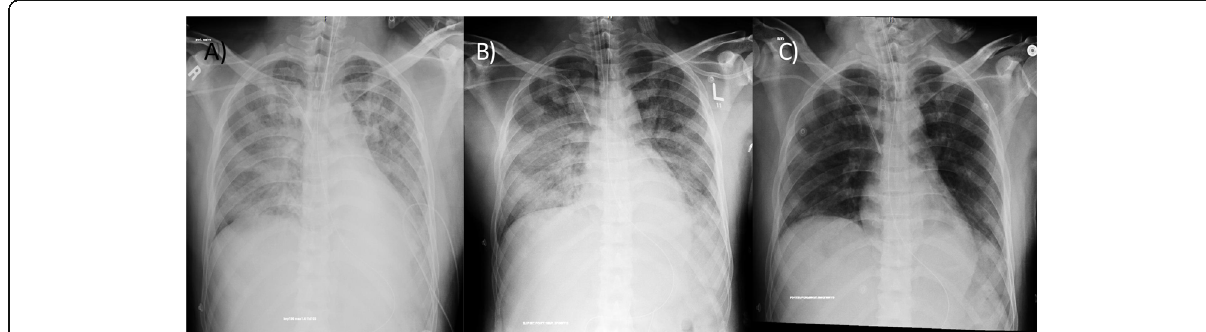
Fig. 6 Case 65: a 38-year-old male, with mild obesity, no other comorbidities, score 7 under vasopressor treatment. Chest X-ray: a day of inclusion (April 16th). Extensive consolidations involving both lung fields with left retrocardiac volume loss. Blunting of the left CP angle. Ill-defined opacities seen in bilateral lower zones. b Day 4 after treatment (April 20th). Improved appearance of patchy airspace opacity in the whole left lung with almost resolved bilateral pleural effusion and underlying atelectasis; however, consolidation is again noted in the left retrocardiac area with mild worsening of airspace opacity in the right mid and lower zones. c Day 9 after treatment (April 25th). Regression of patchy airspace opacification mid-right and left lung when compared to the previous study. Residual patchy bilateral airspace opacification particularly in the left retrocardiac region